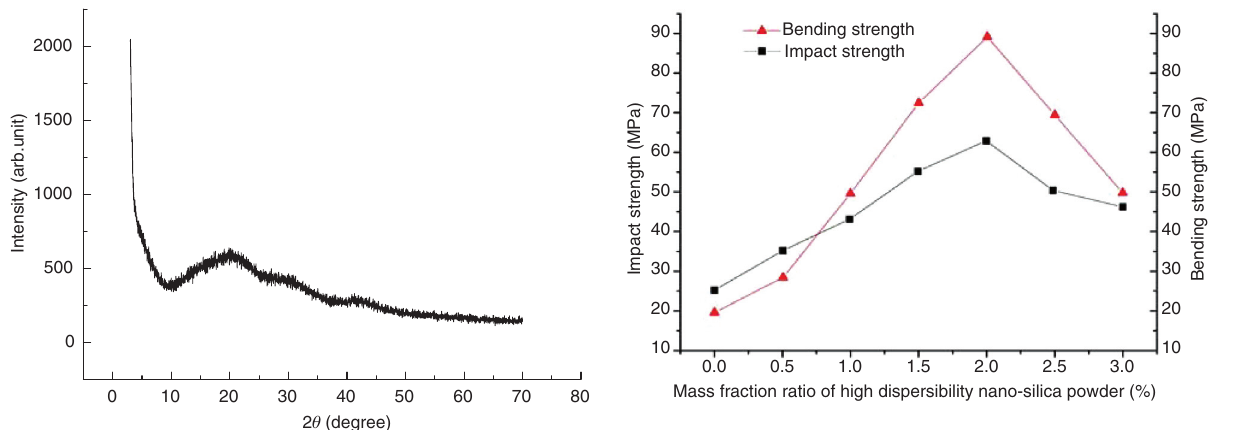
Figure 6 XRD pattern of unmodified nano-silica powder.